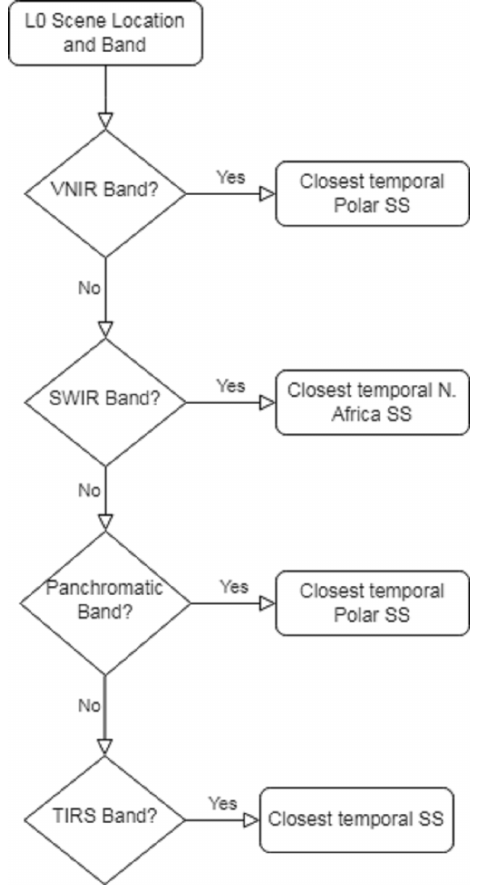
Figure 13. Flowchart for determining which side slither to use based on band and scene